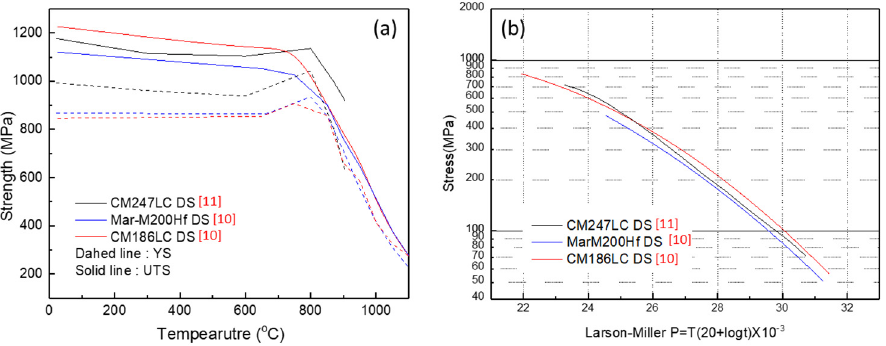
Figure 2. Mechanical properties of directional solidified (DS) superalloys, ( a ) strength, ( b ) Larson- Miller plot